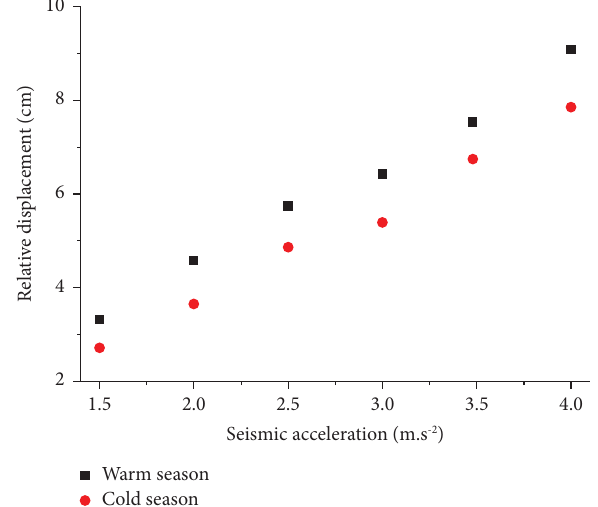
Figure 11: Te distribution of the maximum relative